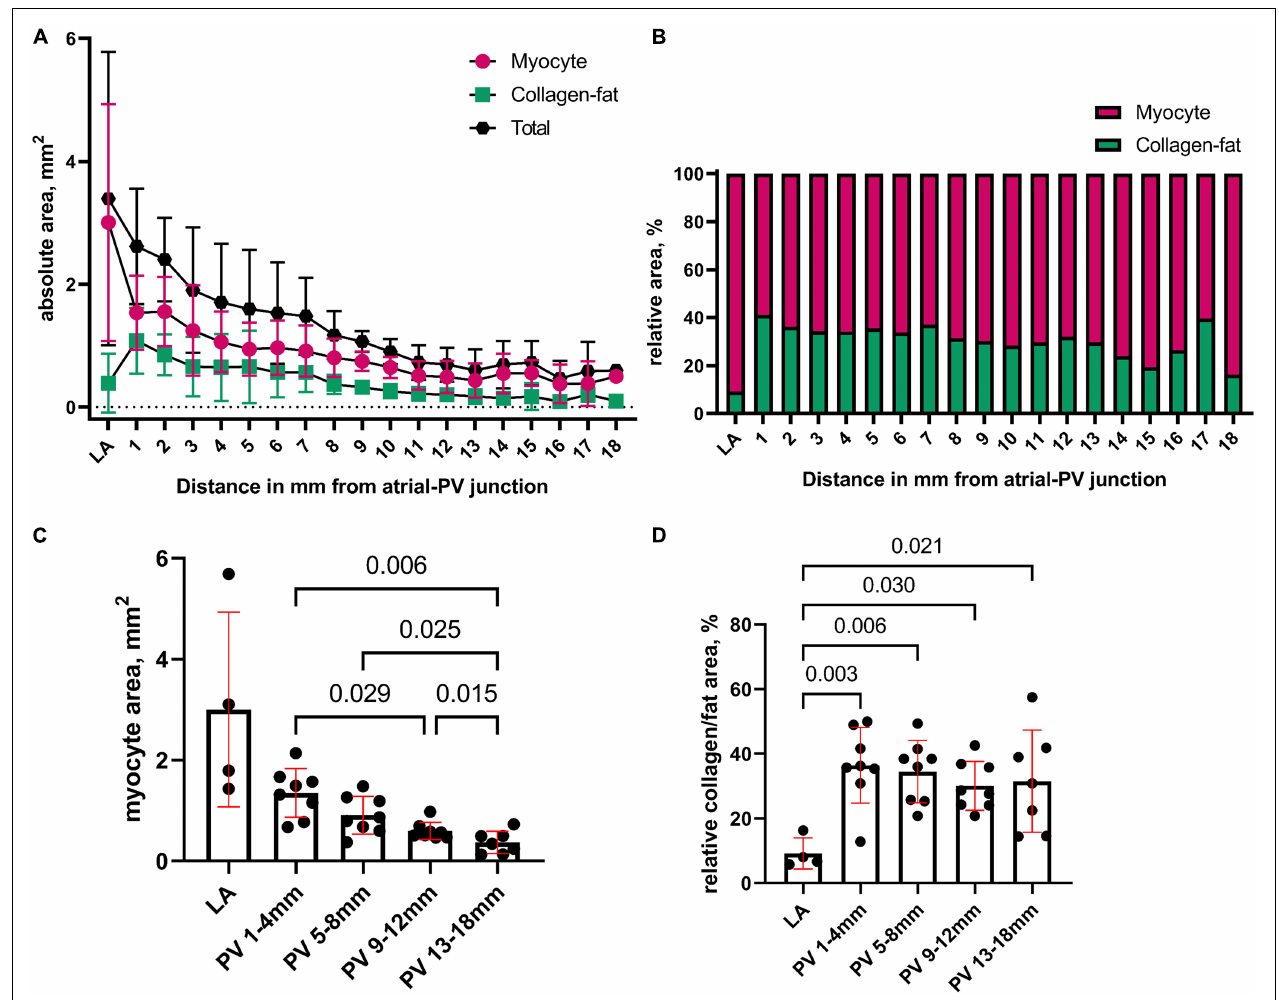
FIGURE 3 | Quantification of the structural composites in the pulmonary vein. (A) We quantified the area of myocytes and of collagen-fat tissue (between the myocytes) in the LA and every 1 mm from proximal to distal PV. The total tissue area is area myocyte + area collagen − fat . (B) Relative percentage of myocytes and of collagen-fat tissue in the LA and PV. (C) The myocyte area was pooled in 5 anatomical groups (4 PV groups going from proximal to distal: 1–4 mm, 5–8 mm, 9–12 mm, and 13–18 mm; and 1 LA group). The proximal PV contained significantly more myocytes than the distal PV. (D) The relative content of collagen and fat tissue between the myocytes was statistically higher in the PV myocardium than in the LA but did not differ between the proximal and distal PVs. Bars: mean values. Error bars: standard deviation. Mixed-effects linear models were used for the statistical testing, and Tukey correction was applied for multiple